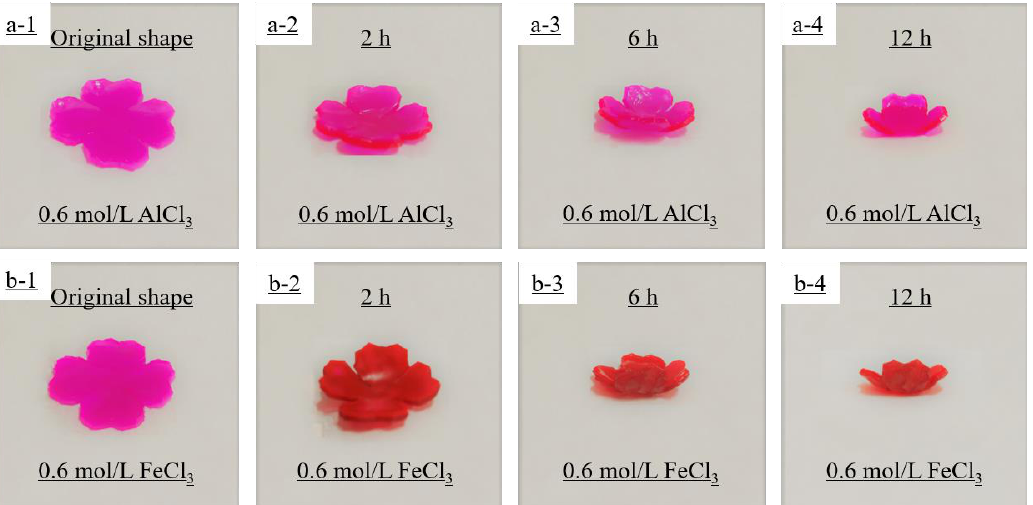
Figure 6. Simulative petal closure process of the four-leaf clover hydrogel actuator when immersed in 0.6 mol/L AlCl 3 ( a1 – a4 ), with the NIPAM hydrogel layer on top and the AAm/AAc hydrogel layer on the bottom, or 0.6 mol/L FeCl 3 ( b1 – b4 ), with the AAm/AAc hydrogel layer on top and the NIPAM hydrogel layer on the bottom.